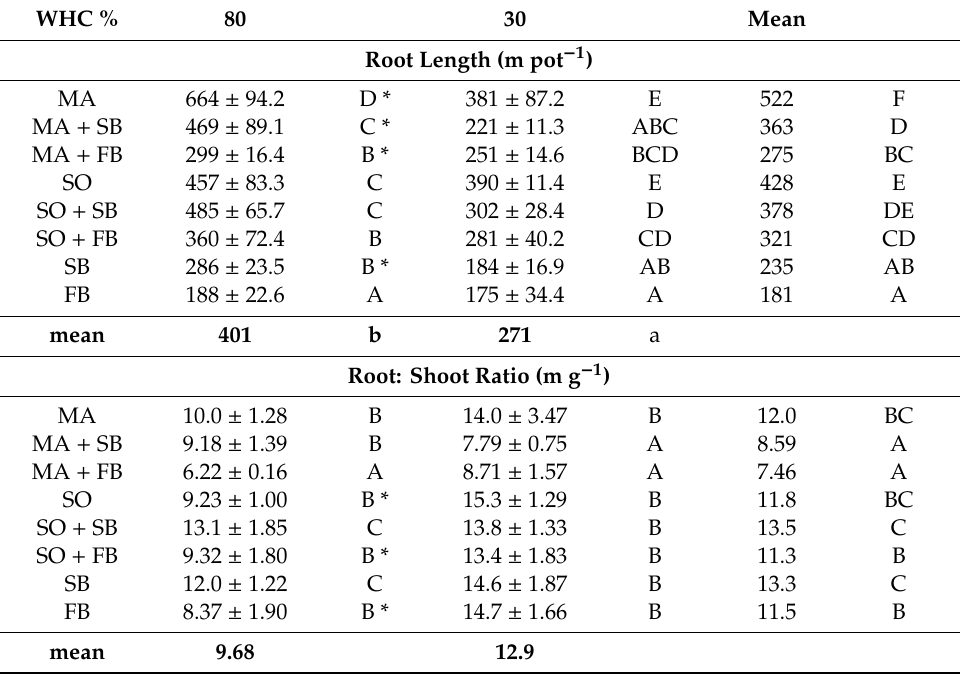
Table A6. E ff ect of water supply on root length and root:shoot ratio of the crops and mixtures in the Water-Trial (mean ±